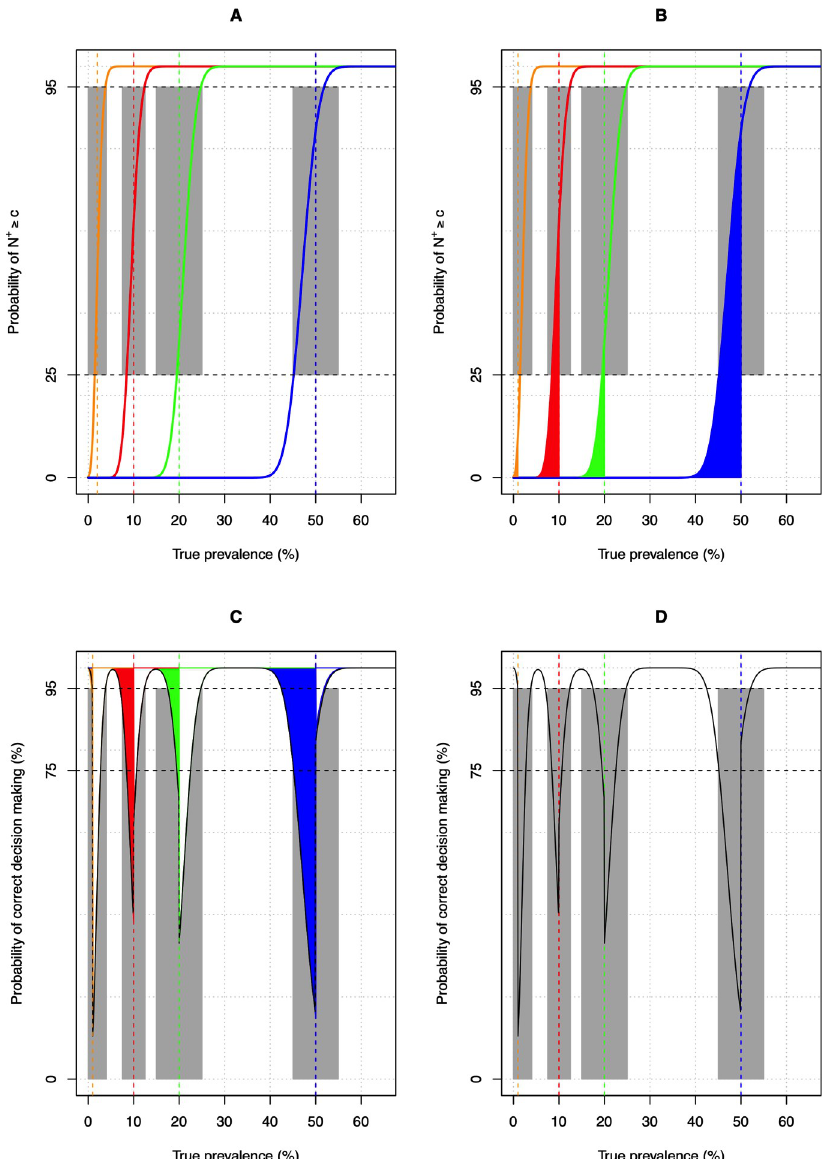
Fig 3. The build-up of multi-category LQAS for STH control program decision making using an imperfect test. The different panels illustrate the build-up of a multi-category LQAS around 4 program decision thresholds T (2%, 10%, 20% and 50%) when applying an imperfect test (sensitivity ( Se d ) = 76% and specificity ( Sp d ) = 99%) on 500 ). Panel A provides the provides the probability (in %) of the number of positive test randomly selected subjects ( N tot results ( N + ) in a random sample of N tot subjects (= 500) being at least c separately for each of the 4 thresholds, their corresponding decision cut-offs ( c 2% = 13, c 10% = 41, c 20% = 84, c 50% = 182) and true underlying prevalence Prev true ( Prev true < 2% : 0.0%, Prev true � 2% : 4.0%; Prev true < 10% : 7.5%, Prev true � 10 : 12.5%; Prev true < 20% : 15.0%, Prev true � 20% : 25.0%; Prev true < 50 % : 45.0%, Prev true � 50 : 55.0%). Note that these Prev true -values define the borders of the grey zone around the program thresholds and for these Prev true -values ε overtreat � 25% and ε undertreat � 5%. The vertical straight line represents the program decision threshold T (orange: 2%, red: 10%, green: 20% and blue: 50%). The horizontal black dashed lines represent a ε equal to 25% and a ε equal to 5% (= 100% - 95%). The grey zone indicates the range of overtreat undertreat Prev true for which decision making is inadequate ( ε overtreat > 25% and ε undertreat > 5%). Panel B provides the same information as Panel A, but highlights the error of falsely scaling up the PC frequency (solid surfaces). Panels C and D represent the probability of correct program decision making across a wide range of Prev true , where Panel C provides (colored areas) in the program decision an overview of the relative contribution of ε overtreat